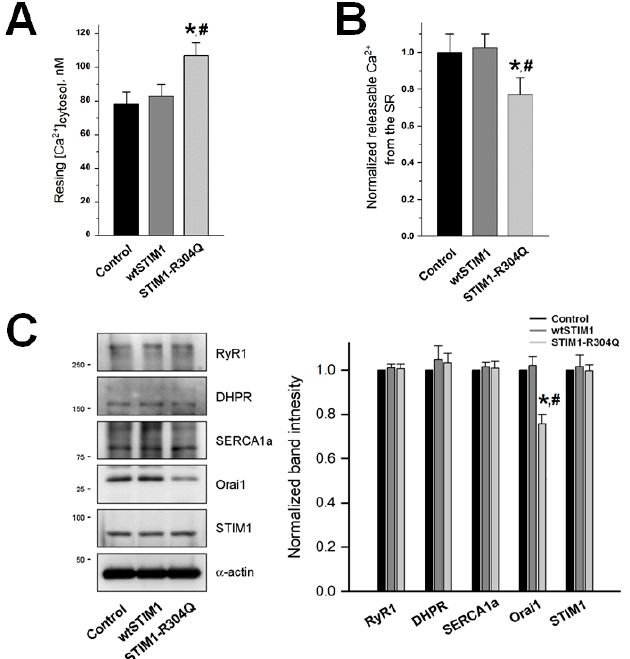
Figure 3. Cytosolic Ca 2+ levels, the amount of Ca 2+ releasable from the SR, and expression levels of Ca 2+ movement-mediating proteins: ( A ) cytosolic Ca 2+ levels at rest were measured in wtSTIM1- or STIM1-R304Q-expressing myotubes, and the mean values are summarized as histograms (Table 1); ( B ) amount of Ca 2+ releasable from the SR to the cytosol was measured in the myotubes by treatment with thapsigargin (2.5 μ M) in the absence of extracellular Ca 2+ . The mean values of each normalized to the mean value of the control are summarized as histograms (Table 1); ( C ) the lysate of the myotubes was subjected to immunoblot assays with antibodies against five proteins. α -actin was used as a loading control. The expression level of each protein normalized to the value of each control is presented as histograms (Supplementary Table S2). * Significant difference compared with control ( p < 0.05). # Significant difference compared with wtSTIM1 ( p < 0.05).